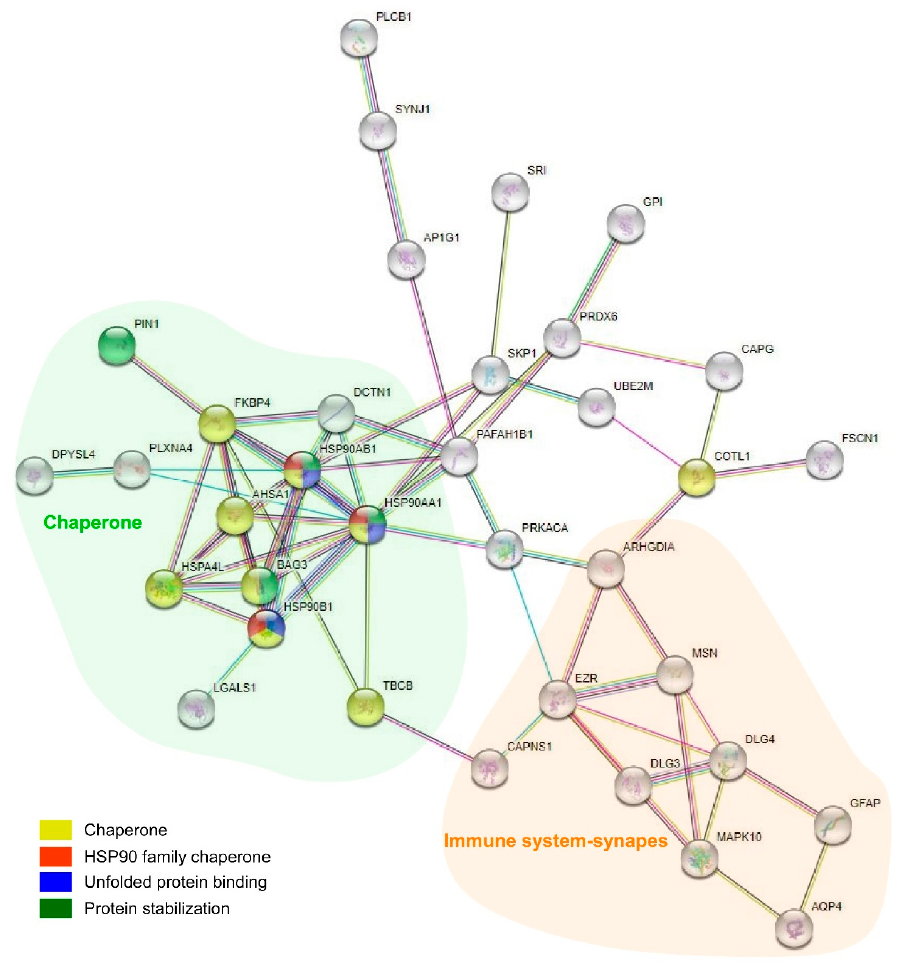
Figure 6. Protein–protein interaction (PPI) analysis revealed a complex interaction between proteins, with clusters related to astrocytes, synapses, and chaperones. Immune system-/synapse-related proteins are within the orange cloud, and chaperones are within the green cloud. Proteins that belong to the Hsp90 family of chaperones are highlighted in red, genes enriched in the molecular function unfolded protein binding are highlighted in blue, and genes enriched in the biological process protein stabilization are highlighted in green. Note that HSP90AB1 and HSP90AA1 are involved in all identified functions in the analysis. In addition, BAG3 is related to protein stabilization.